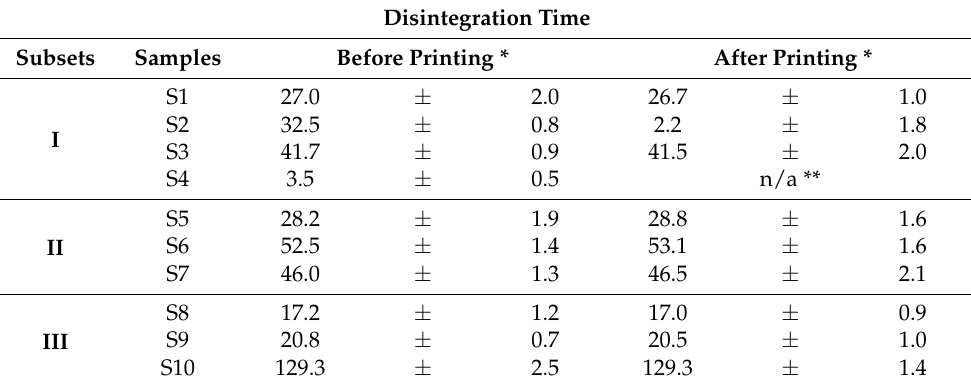
Table 3. Investigated samples disintegration before and after five printing